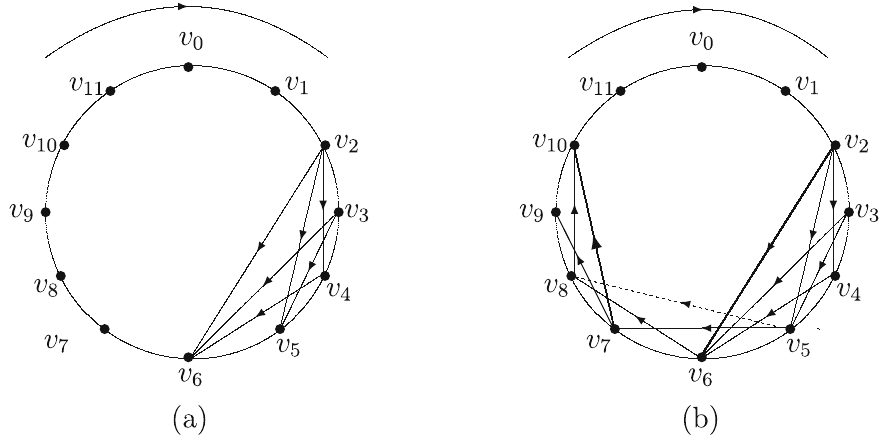
Figure 5: ( ) a v v 2 6 isamaximalcrossarcon = C v